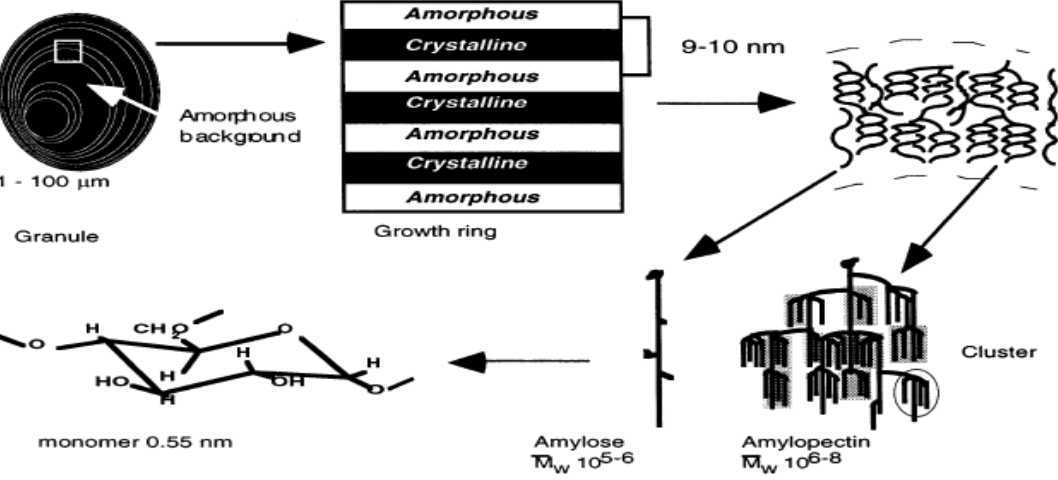
Figure 2. Schematic representation of different structural levels of the starch granule and the involvement of amylose and amylopectin in developing starch molecules [64].